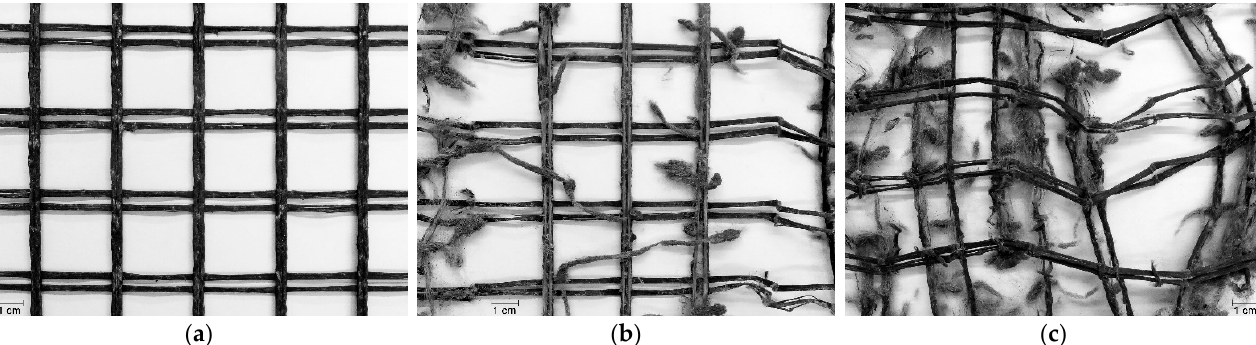
Figure 7. Visual inspection of WG-I after the degradation tests: ( a ) single exposure to MD tests; ( b ) single exposure to abrasion tests; ( c ) successive exposure to MD and abrasion tests.